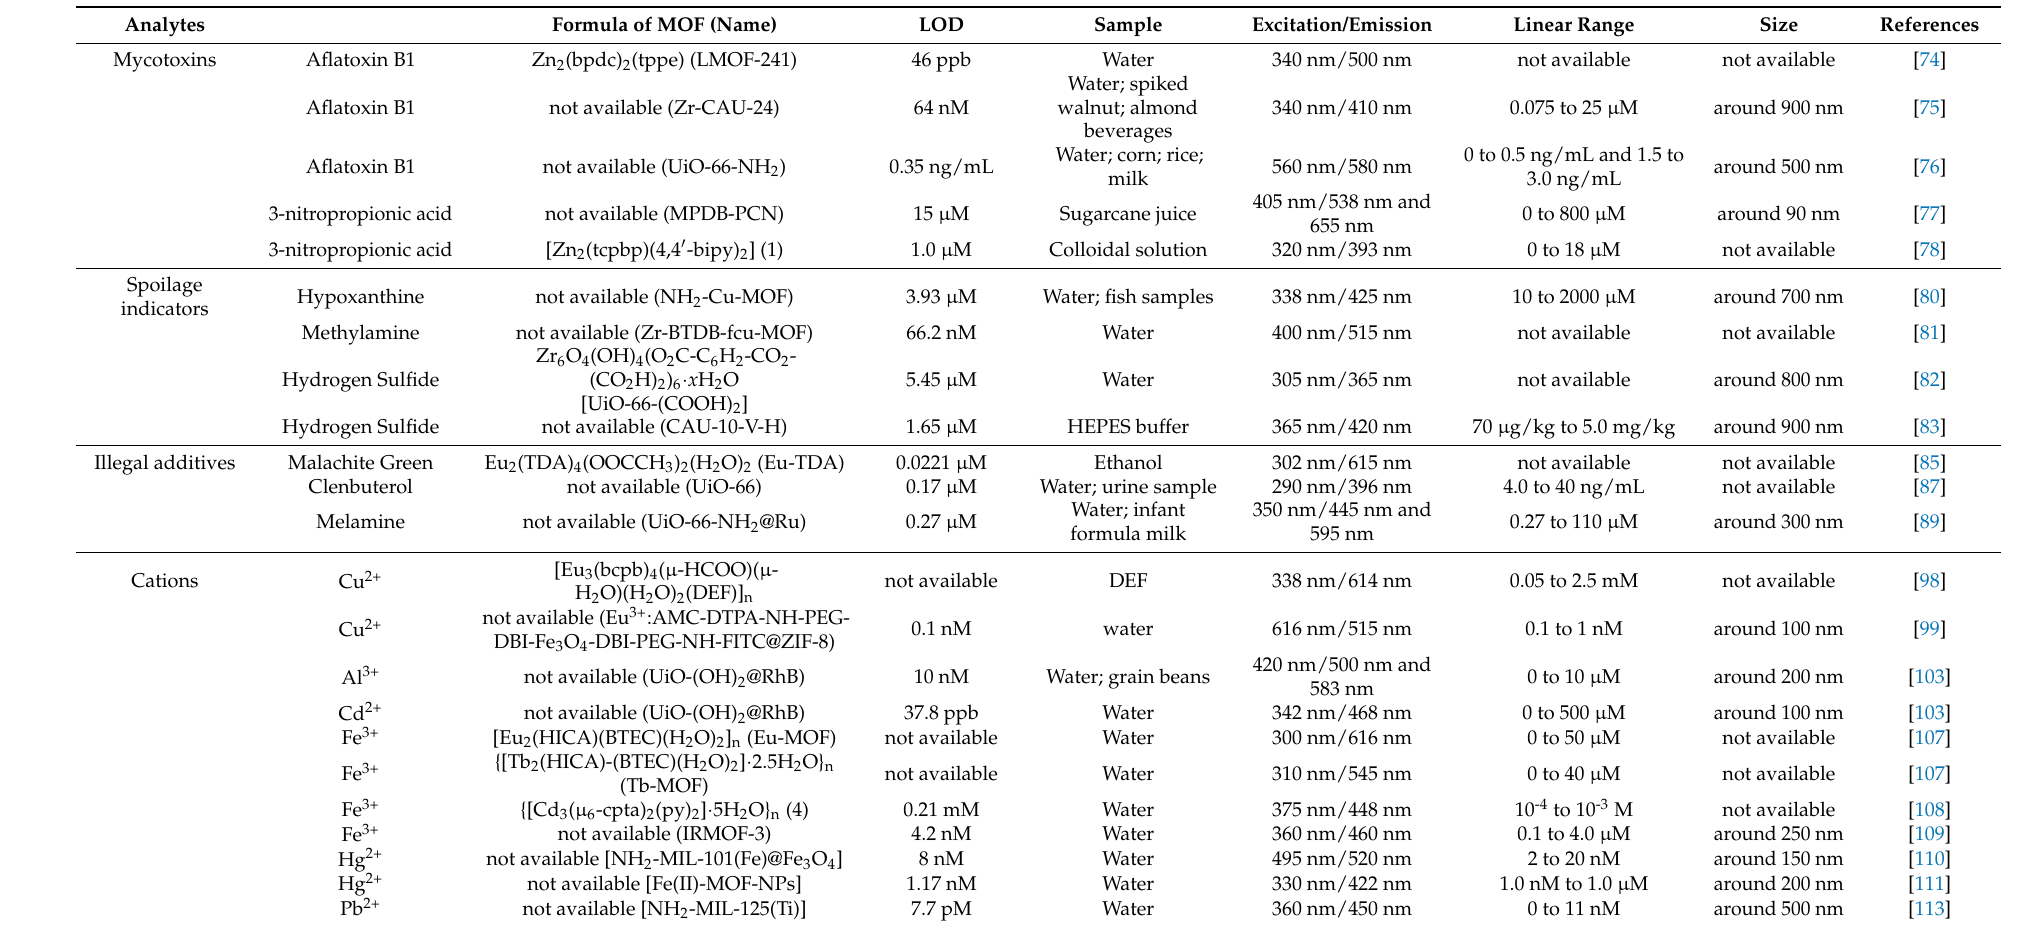
Table 3. A summary of representative examples of NMOFs for food